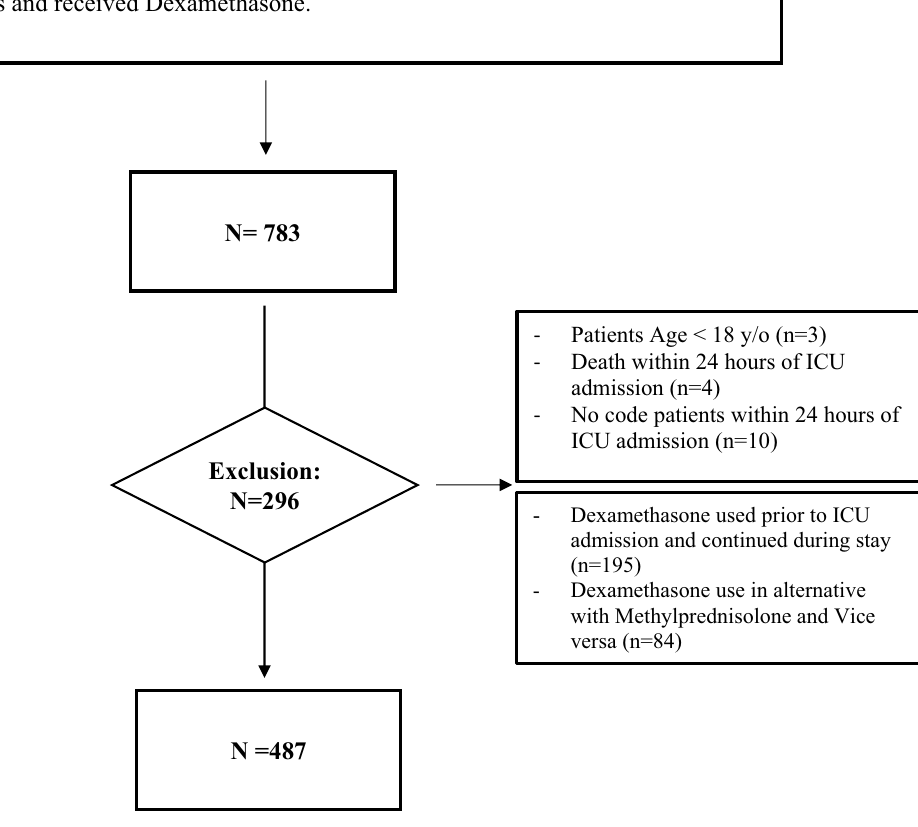
Figure 1. Flow diagram showing patients recruited with COVID-19 who received dexamethasone. COVID- 19 coronavirus disease, ICU intensive care unit, LOS length of